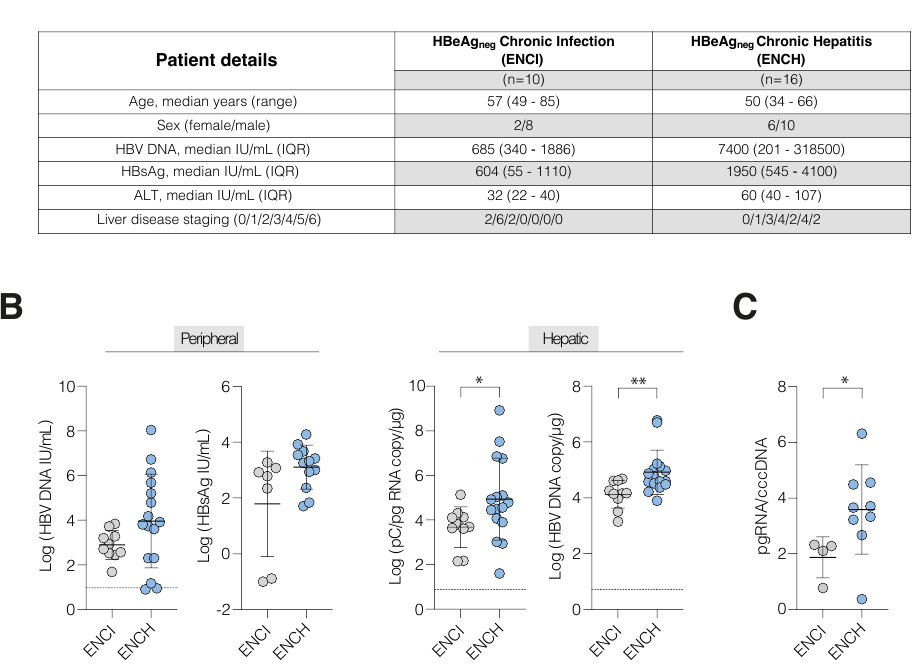
Figure 1. HBV replication in chronic disease. ( A ) Clinical parameters of HBeAg-negative CHB in patients diagnosed with chronic infection (ENCI, n = 10) or chronic hepatitis (ENCH, n = 16) according to EASL guidelines. ( B ) Peripheral HBV DNA, HBsAg, and hepatic pC/pg RNA and HBV DNA levels in ENCI (grey symbols) and ENCH (blue symbols). HBsAg only available for 19 samples. ( C ) The cccDNA transcriptional activity measured as the ratio of pC/pg RNA to cccDNA. Data are presented as the mean copy number derived from two technical replicates and compared using a Mann–Whitney U-test (* p < 0.05, ** p < 0.01). The dashed line denotes the cut-off of the